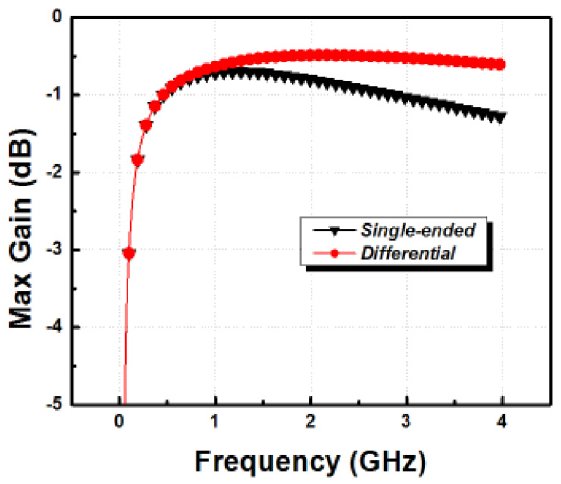
Figure 18. Simulated transformer maximum gain for single-ended and differential cases.